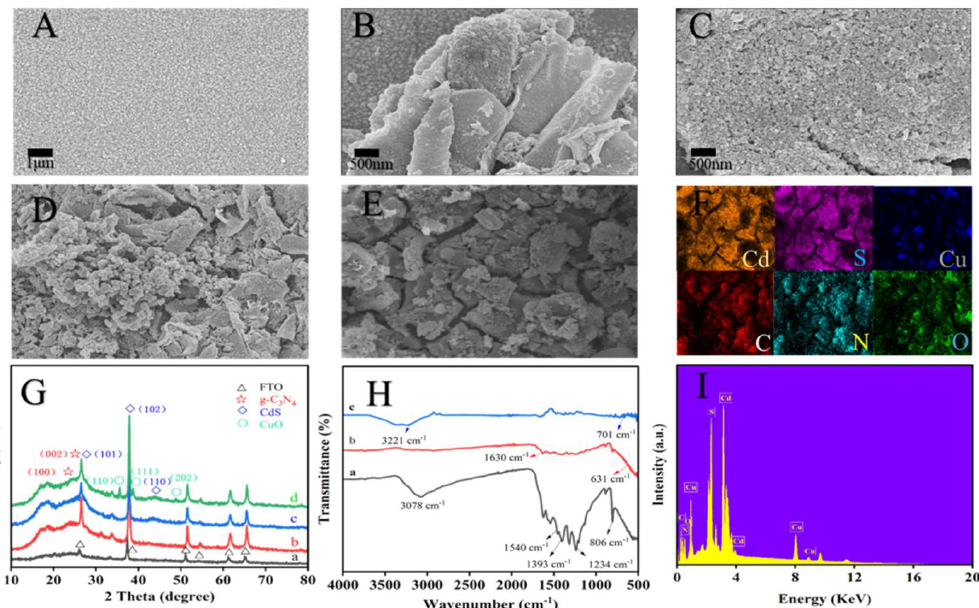
Figure 1. SEM images of naked FTO ( A ), g-C 3 N 4 ( B ), CdS ( C ) and CuO ( D ); ( E , F ) SEM mapping image; XRD ( G ) includes a: FTO, b: g-C 3 N 4 /FTO, c: CdS-g-C 3 N 4 /FTO, d: CuO-CdS-g-C 3 N 4 /FTO; FT-IR ( H ) of a: g-C 3 N 4 , b: CdS and c: CuO; and ( I ) EDX spectrum of g-C 3 N 4 -CdS-CuO.